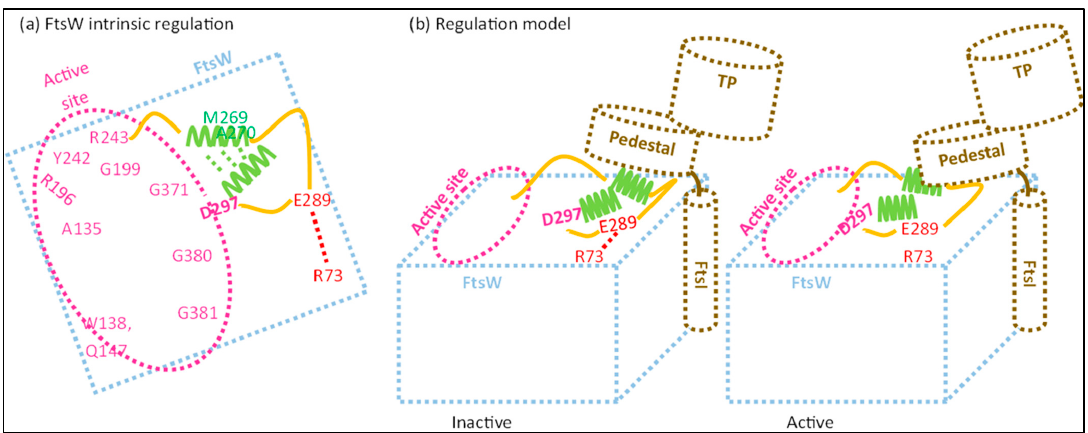
Figure 6. Intrinsic FtsWI regulation. FtsWI appear to have an intrinsic regulatory mechanism, which is expected to be affected by regulators. In a simplified scheme of the periplasmic side of FtsW ( a ), the catalytic residue D297 is located at the periphery of the active side (purple–dotted ring) in the loop between TM7 and TM8 that also contains the inhibiting E289 residue and the activating M269 and A270 residues. A balance between these two regions on the same loop appear to regulate FtsW GTase activity. A putative interaction between E289 and R73, located on TM1, likely destabilizes or sequesters D297 from the rest of the active site, leading to an inactive conformation. The hydrophobic region around M269 and A270 may antagonize this and lead to the stable positioning of D297 in the active site. ( b ) A speculative model describing the possible activation of FtsW by FtsI is shown. Regions of the pedestal domain of FtsI may interact with the α -helix containing M269 and A270, pushing the regulatory loop in an active conformation. Regulators may modulate the stability of this interaction, as it is determinative for FtsW GTase activity [19,25]. This is in line with the proposed activation mechanism of RodA by PBP2 [50]. Although the predicted structure of the FtsI-FtsW complex is still putative, it is like the crystal structure of PBP2-RodA. Both the TM domains of PBP2 and FtsI interact tightly with RodA/FtsW TM domains 8 and 9, and both the PBP2/FtsW pedestal domains interact with ECL4 of RodA/FtsW. The only major difference is that RodA-PBP2 complex formation leads to the outward deflection of TM7, creating a membrane-accessible cavity. This cavity was observed in both the structural prediction of FtsW separately and in complex with FtsI. Additionally, Sjodt et al. reported a direct interaction between the PBP2 distal pedestal domain and RodA ECL4 close to TM7, which was not predicted. These differences may be due to the crystal packing effect, as the RodA- PBP2 complex adopts numerous conformations in electron microscopy data [50,72]. In the next section, we present a model where regulators allosterically interact with and stabilize FtsWI, and show that especially an interaction between the distal pedestal domain of FtsI and FtsL is important for accelerated sPG synthesis. 4. Septal Peptidoglycan Synthesis Regulation The sPG synthesis machinery is recruited and regulated by certain factors localized at the midcell. These factors include the conserved subcomplex of the divisome consisting of FtsB, FtsL and FtsQ, and the septation-activating protein FtsN. The FtsBLQ subcomplex and FtsN are involved in the recruitment and regulation of the septal peptidoglycan synthesis in a diverse subset of bacteria including the rod-shaped Bacillus , Escherichia and Pseudomonas genera, and the ovoid-shaped Staphylococcus and Enterococcus bacteria [16,25,73]. The essentiality of the FtsBLQ subcomplex and FtsN, known as the depletion or inactivation of FtsB, FtsL, FtsQ and FtsN, results in extensive cell filamentation in E. coli [17,74,75]. The essentiality of at least FtsL and FtsN is conditional, as (activating) mutations in other divisome components can complement for their depletion or